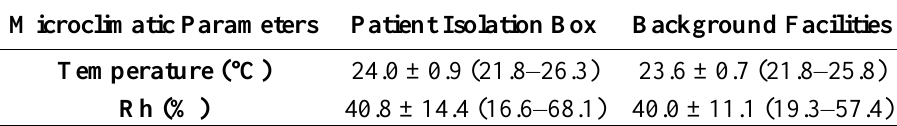
Table 1. Temperature and relative humidity of the cleanroom